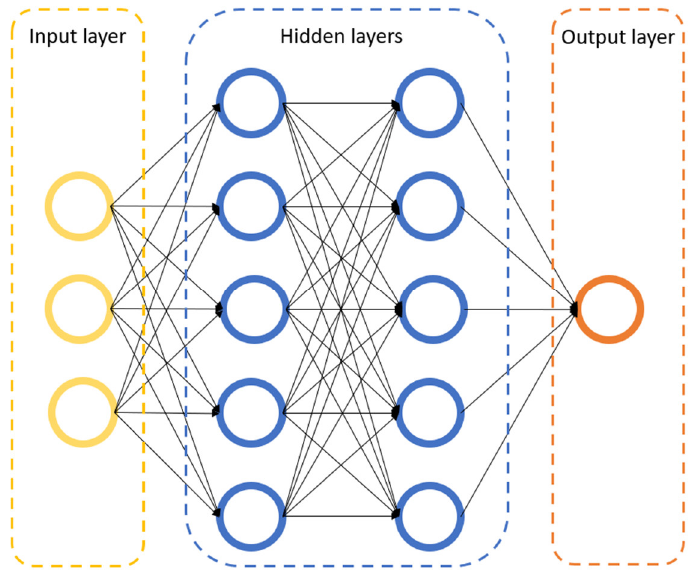
Figure 1. The ANN structure.